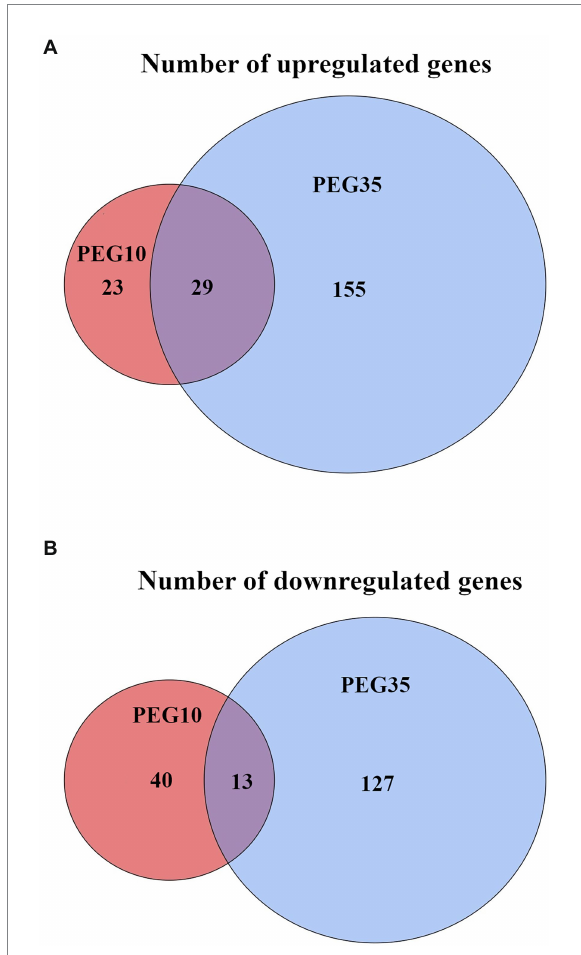
FIGURE 8 Venn diagrams summarizing the DEGs of Arthrobacter sp. Helios in the simulated drought vs. control conditions. (A) Number of upregulated genes in PEG10 vs. PEG0 (red circle) and PEG35 vs. PEG0 (blue circle) comparisons. (B) Number of downregulated genes in PEG10 vs. PEG0 (red circle) and PEG35 vs. PEG0 (blue circle) conditions. Genes are considered differentially expressed when |log 2 FC| ≥ 2 and FDR <